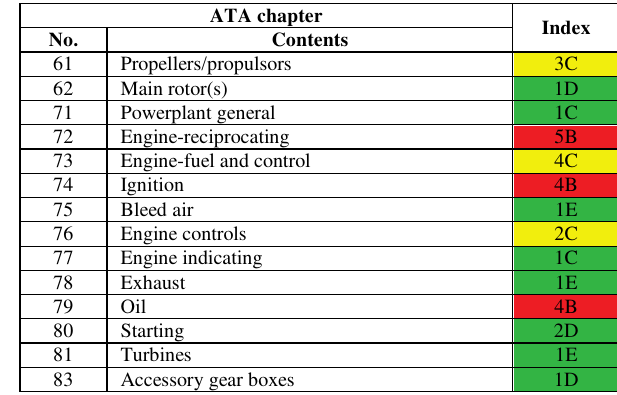
Table 5. Safety risk assessment matrix for piston engine systems